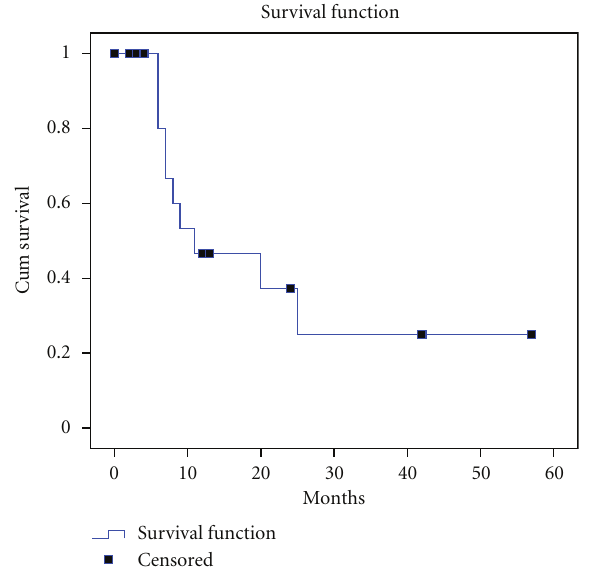
Figure 1: Overall survival of 21 patients with pancreatic cancer treated with complete resection plus hyperthermic intraoperative intraperitoneal